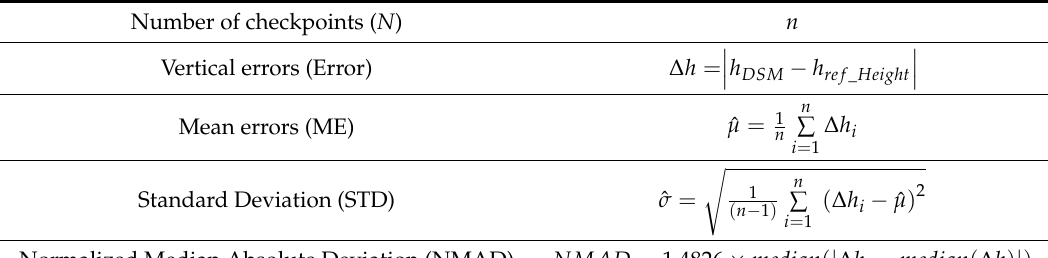
Table 5. Accuracy measures for DSM quality assessment.